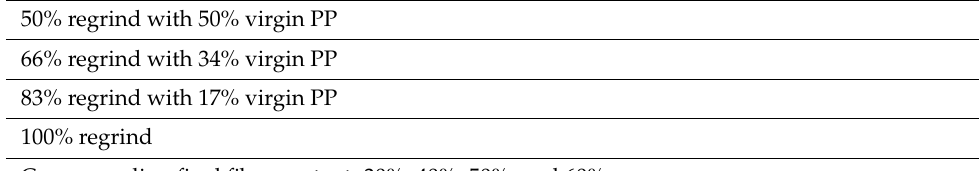
Table 1. Summary of scrap PP-GF material in combination with virgin